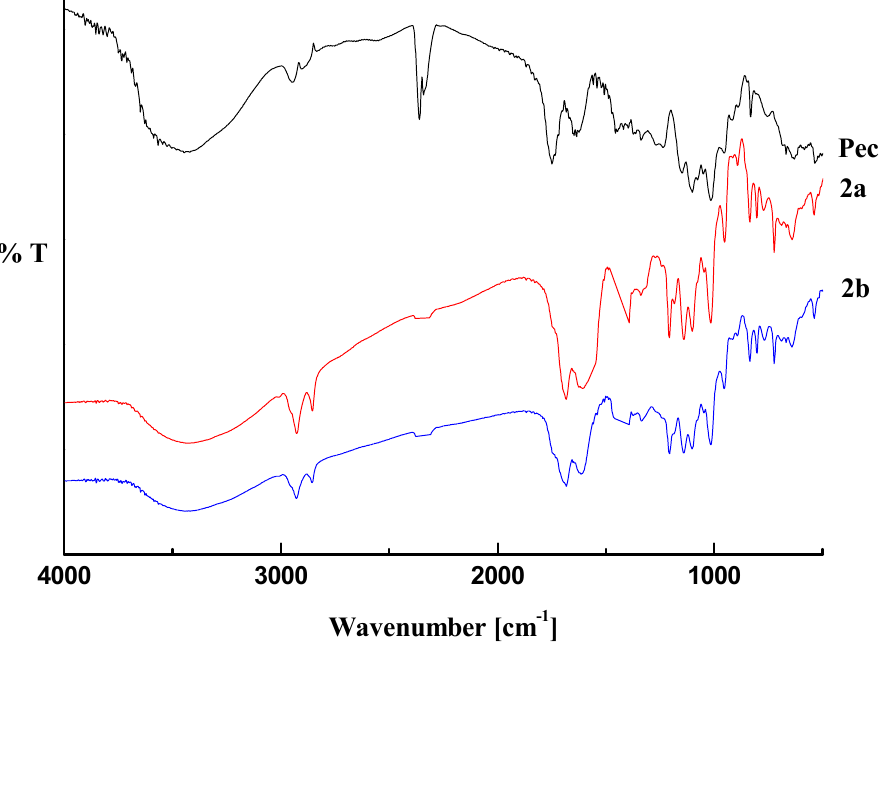
Figure 2. Transmittance FT-IR spectra pectin-oleate ( 2 ) and